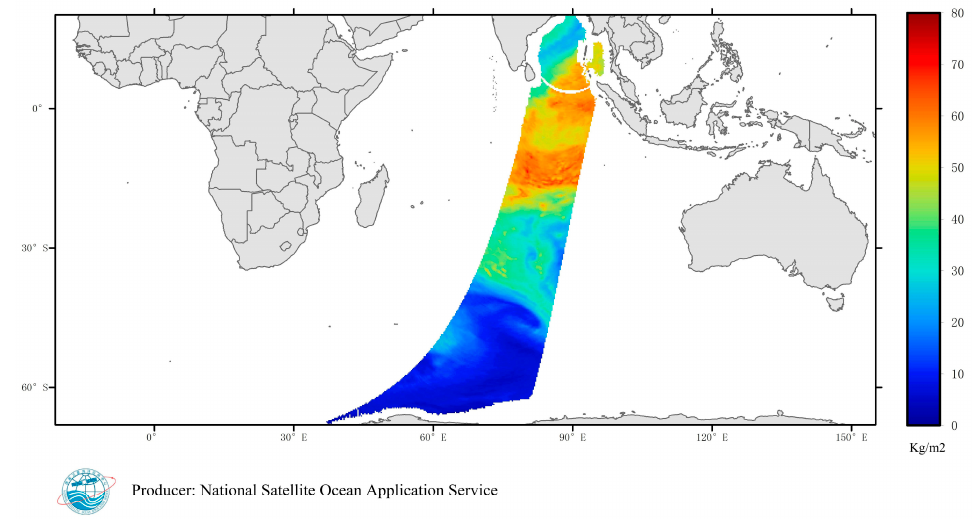
Figure 7. A Water Vapor thematic map of a single HY-2A swath for 25 March 2015 derived from the Customized Processing System. The sample points of water vapor are mapped to a 0.25-degree grid. The colors show the water vapor concentration.